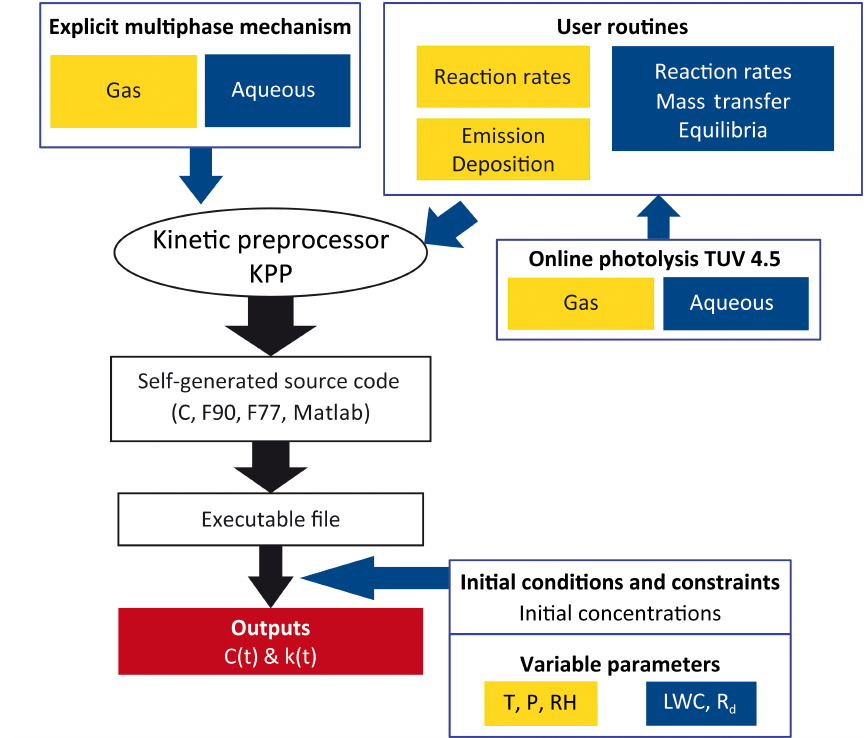
Figure 2. Schematic diagram of the DSMACC version of the Kinetic PreProcessor. The developments related to aqueous phase reactivity are shown in